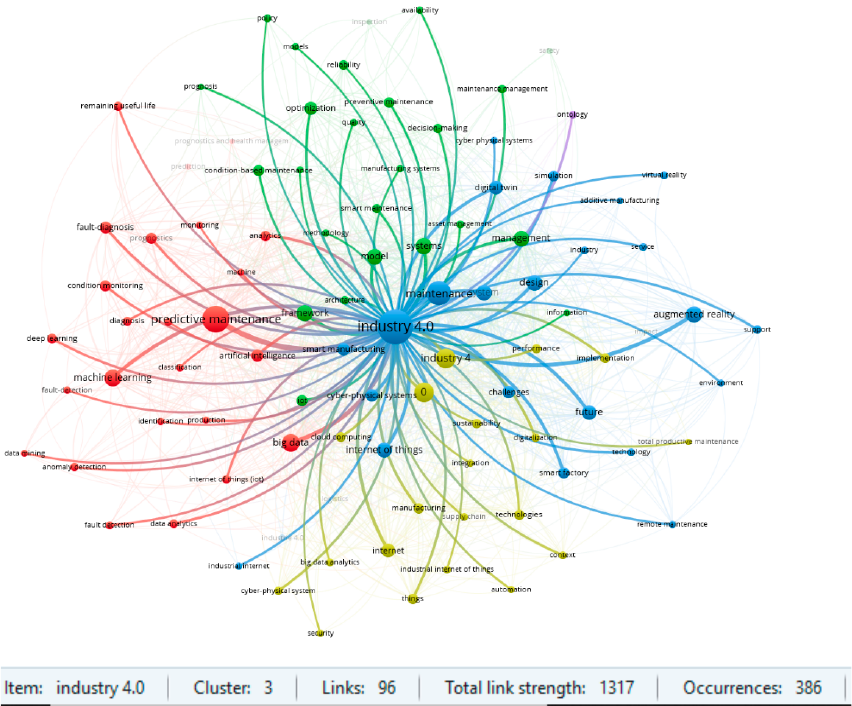
Figure 14. Analysis of keyword strength for the first cluster of publications from the WoS database. Source: own development using VOSviewer software [101].